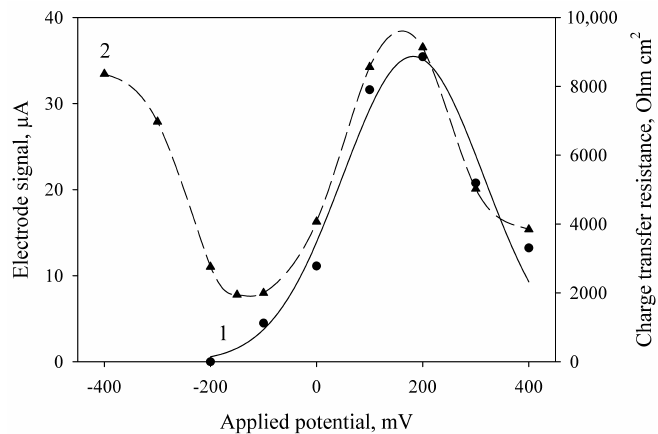
Figure 2. Effect of the applied potential on the electrode signals at the introduction of ethanol (1) and on the electrode charge transfer resistance measured by electrochemical impedance spectroscopy after addition of ethanol (2). The electrode was modified using bacterial cells and chitosan (2:1, v / v ).